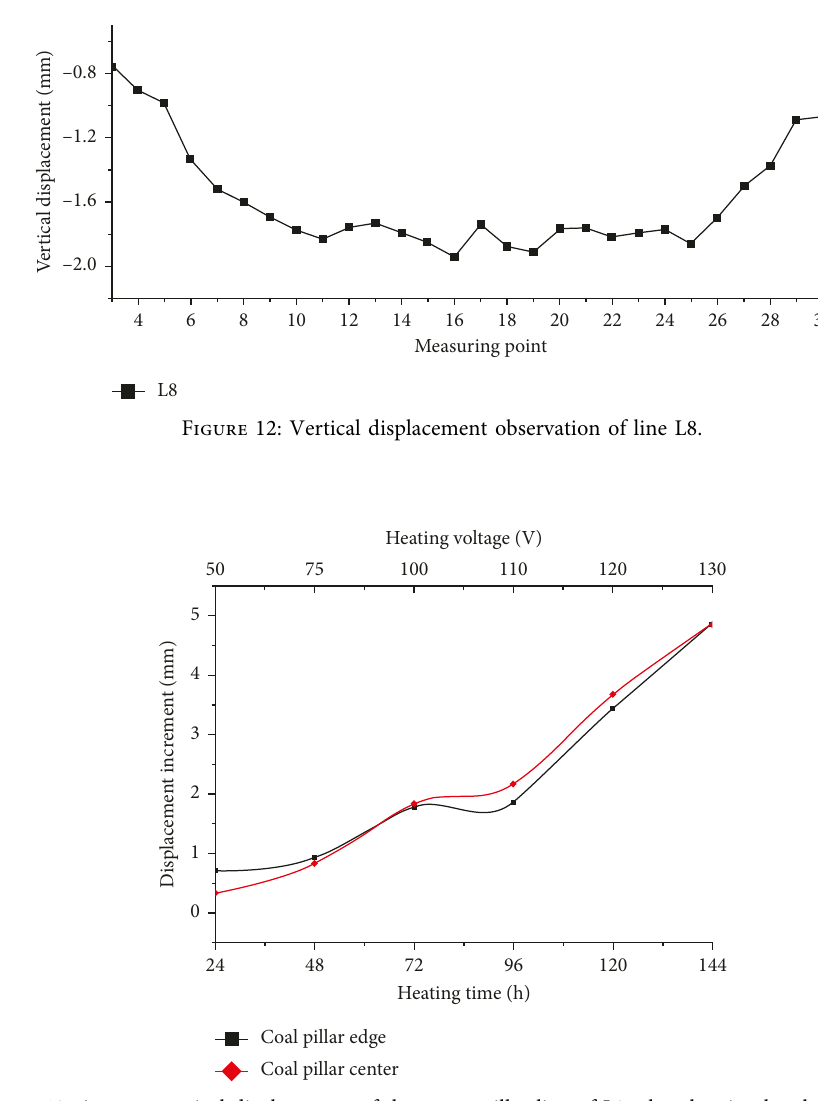
Figure 13: Average vertical displacement of the upper pillar line of L3 when heating by classification.